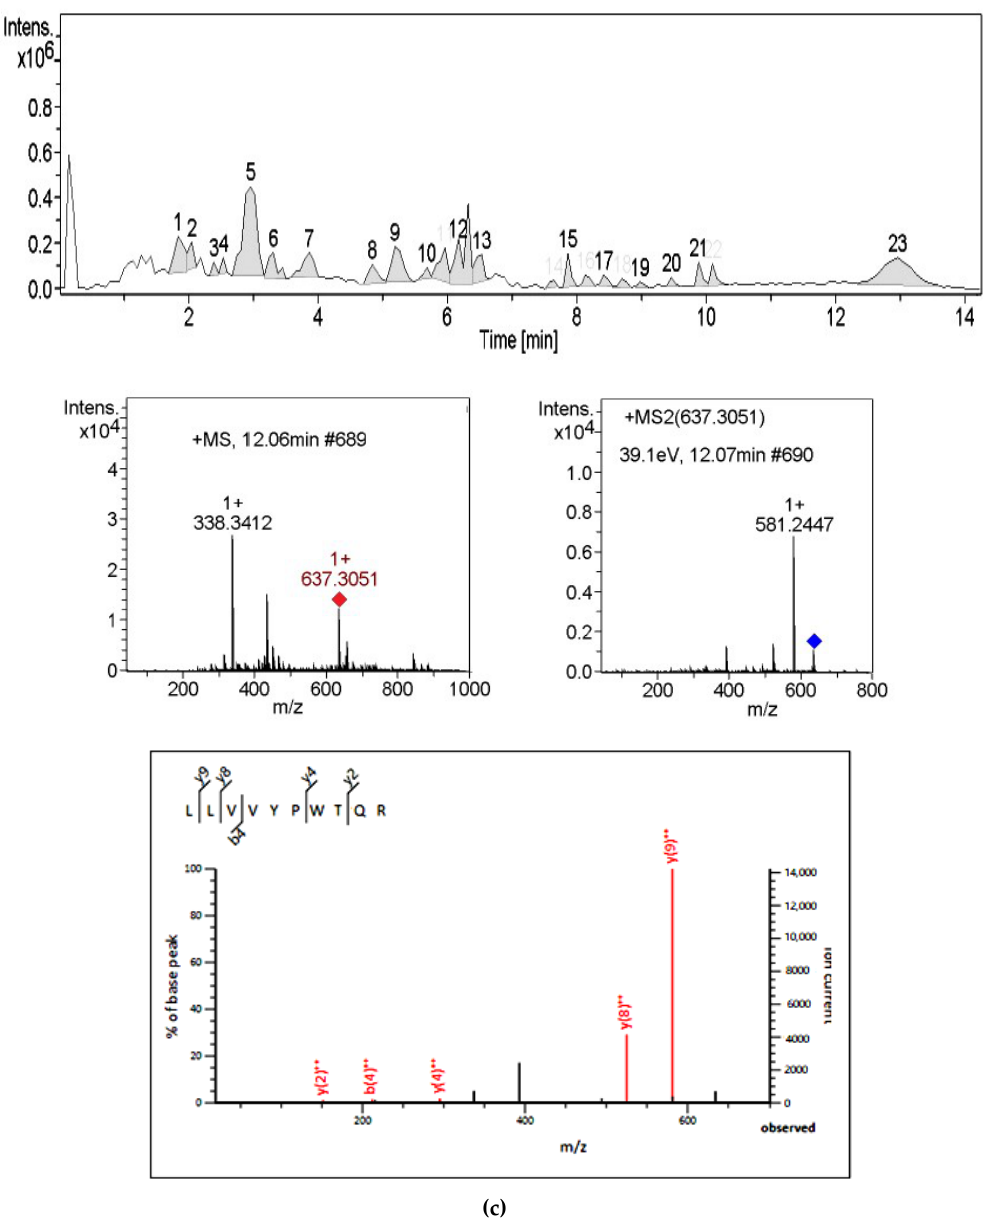
Figure 1. ( a ) The curve of pancreatic lipase inhibitory activity of extracted proteins and enzymatic hydrolysates by Copper soap method; ( b ) elution curve of Alcalase hydrolysis on G25 ( < 5K); ( c ) LC–MS chromatogram of the active fraction A2 from RP-HPLC; MS, MS/MS spectra, and y and b ions spectra of PP1.